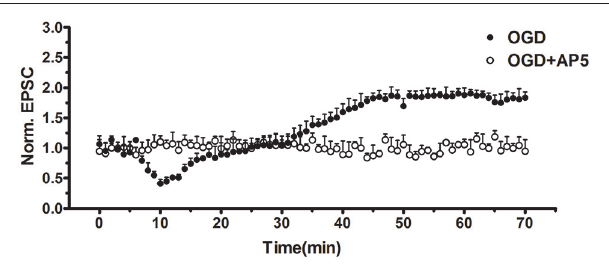
FIGURE 11 | OGD-induced i-LTP was completely abolished by selective NMDAR antagonist AP-5 (50 µ mol/L, n = 5, student’s t -test, p <